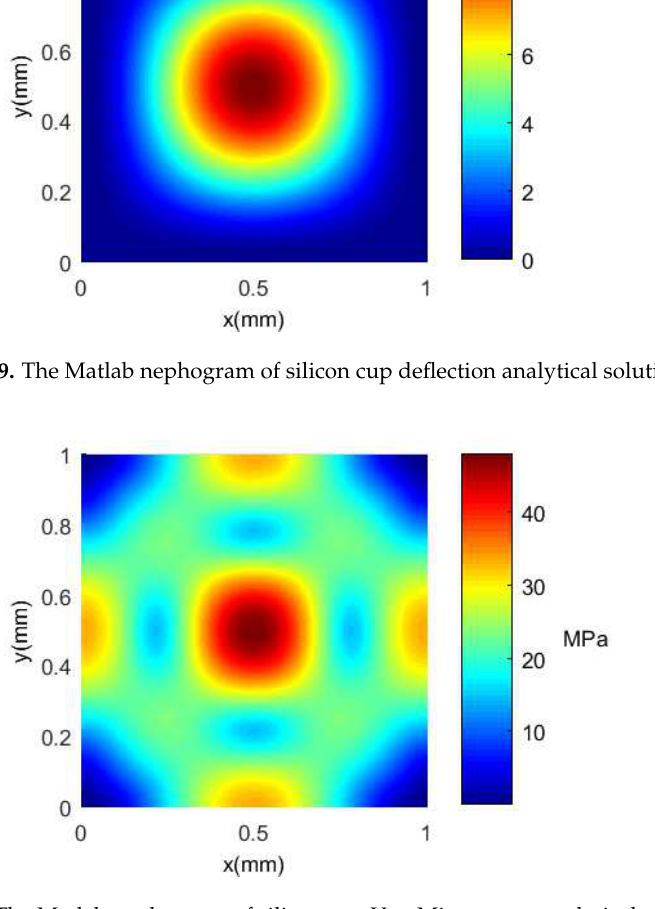
Figure 10. The Matlab nephogram of silicon cup Von-Mises stress analytical